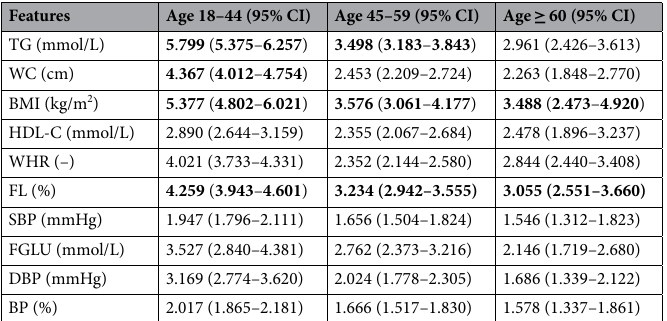
Table 3. The OR of feature’s abnormality to MetS by age groups in male. The result with the best performance in each metric using different classifiers are marked in bold characters.